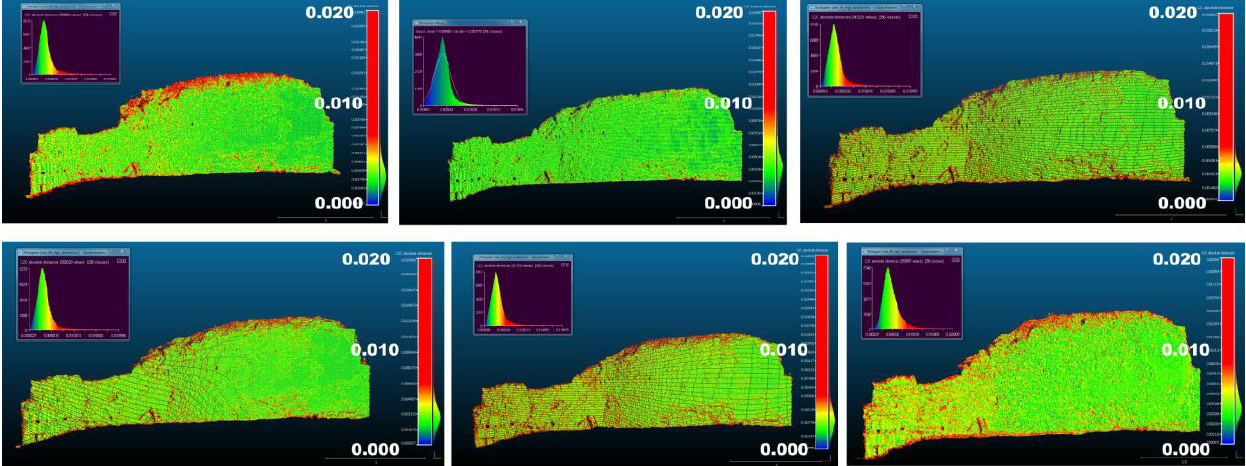
Sample 2: the mean RMSE value for all algorithms with the exception of STAR– 0.25 of the point cloud resolution of the analysed sample. The value for